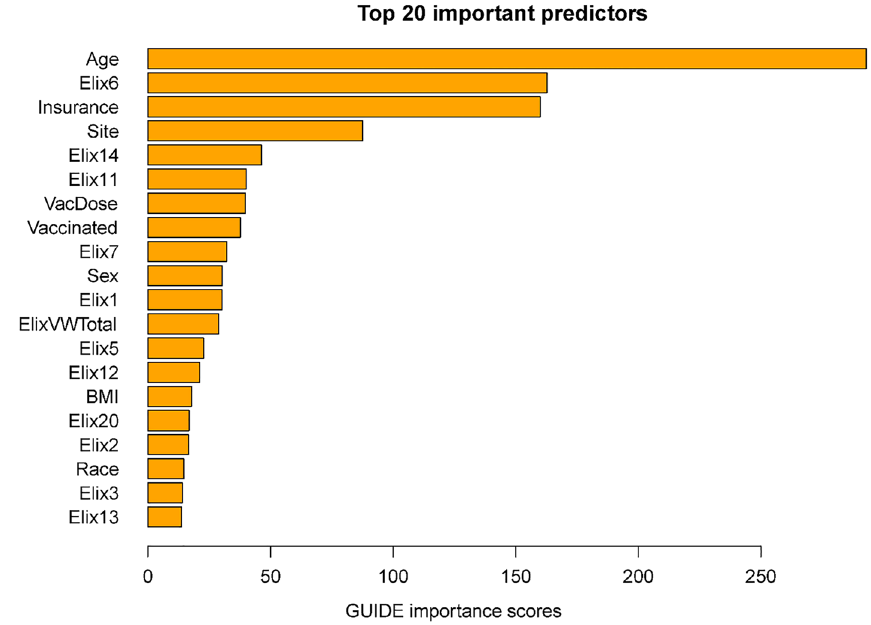
Figure 2. Twenty most important variables and their GUIDE importance scores for predicting mortality from full sample. Elix6 hypertension, uncomplicated, Elix14 renal failure, Elix11 diabetes, uncomplicated, VacDose number of vaccine doses, Vaccinated any vaccine dose (vs. none), Elix7 Hypertension, complicated. Elix1 Congestive heart failure, ElixVWTotal weighted comorbidity total score, Elix5 peripheral vascular disorders, Elix12 diabetes, complicated, Elix20 solid tumor without metastasis, Elix2 cardiac arrhythmias, Elix3 valvular diseases, Elix13